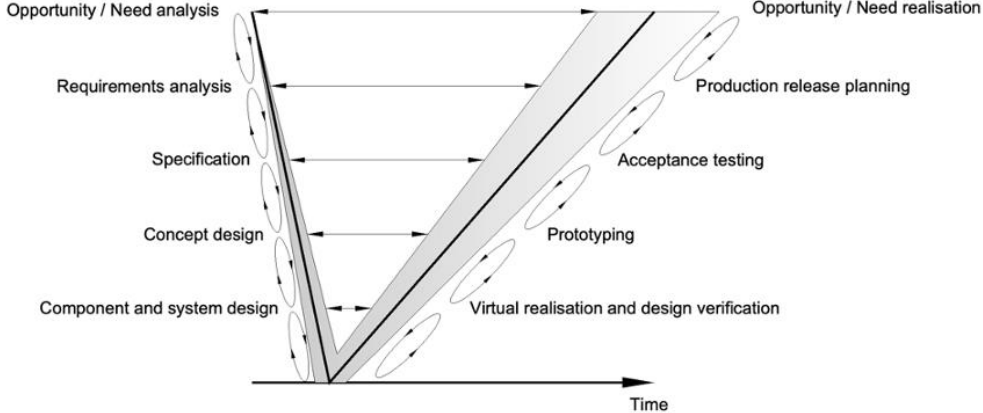
Figure 2. Blended design process, i.e., the skewed V-diagram [36].